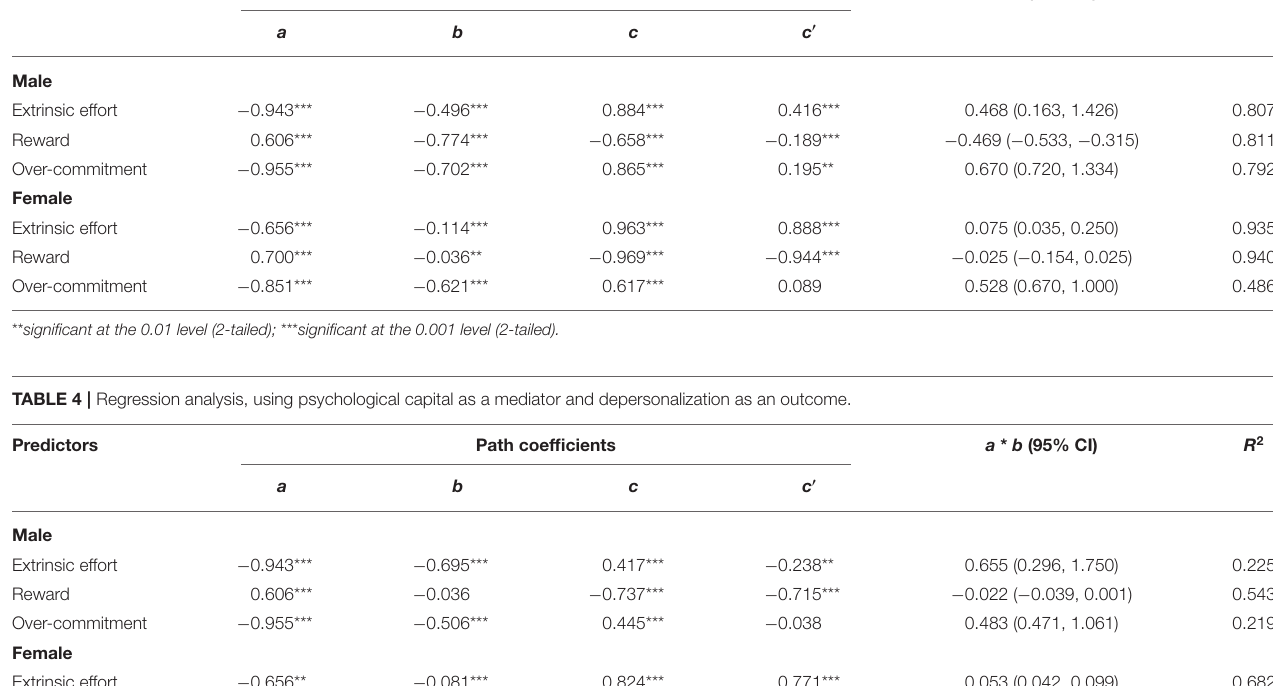
TABLE 3 | Regression analysis, using psychological capital as a mediator and emotional exhaustion as an outcome. Predictors